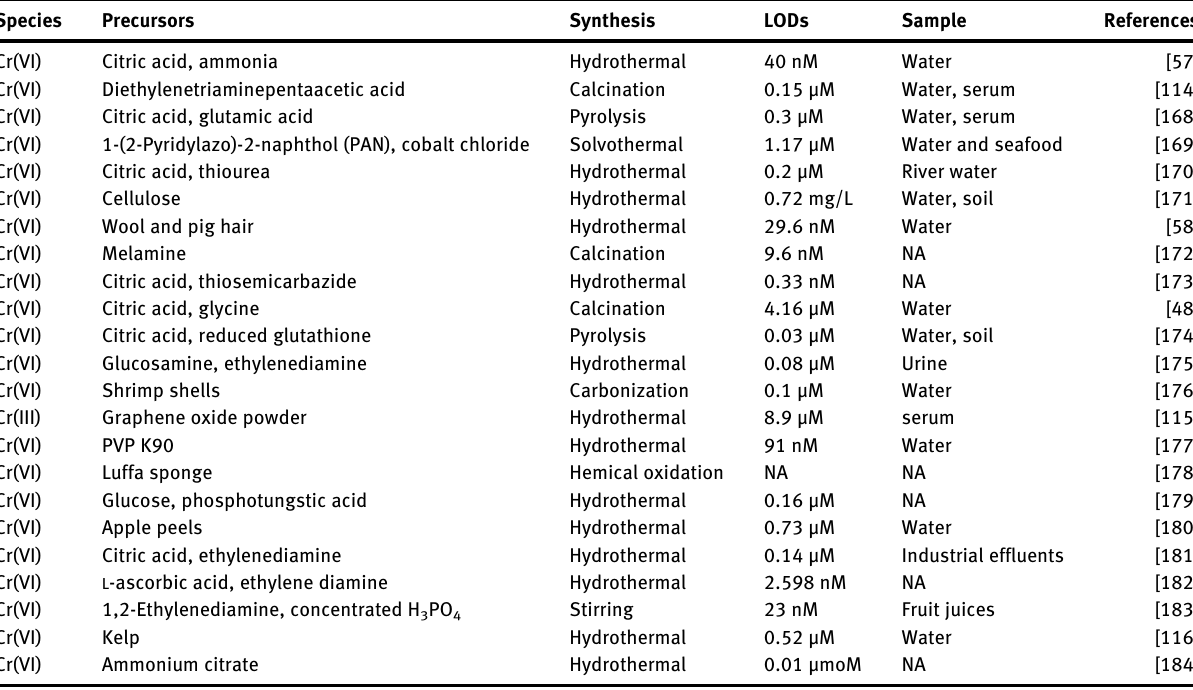
Table  : Typical applications of CD-based fl uorescence sensor for speciation of Cr(VI) and Cr(III).